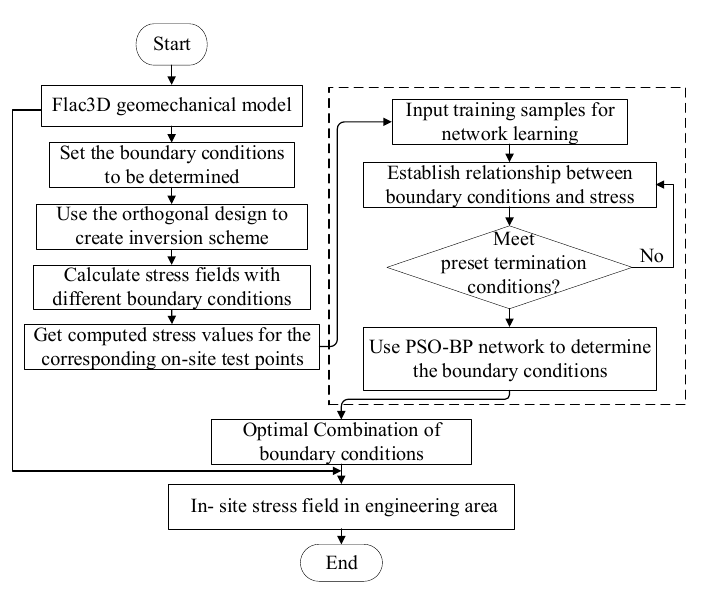
Figure 2. Flow chart of the PSO-BP in situ stress inversion method.